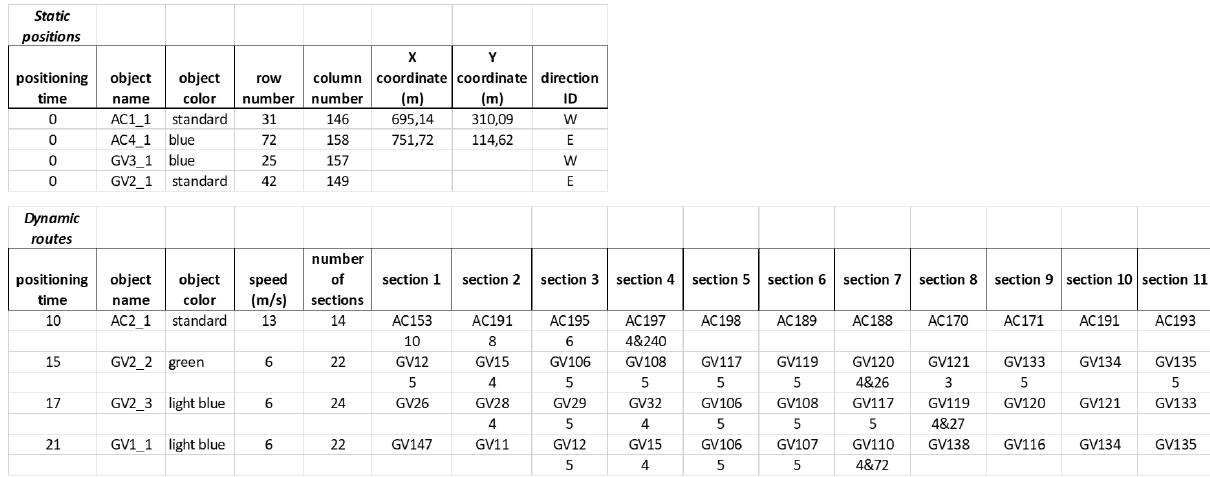
Figure 3. Screenshot of the “Static positions” and “Dynamic routes”